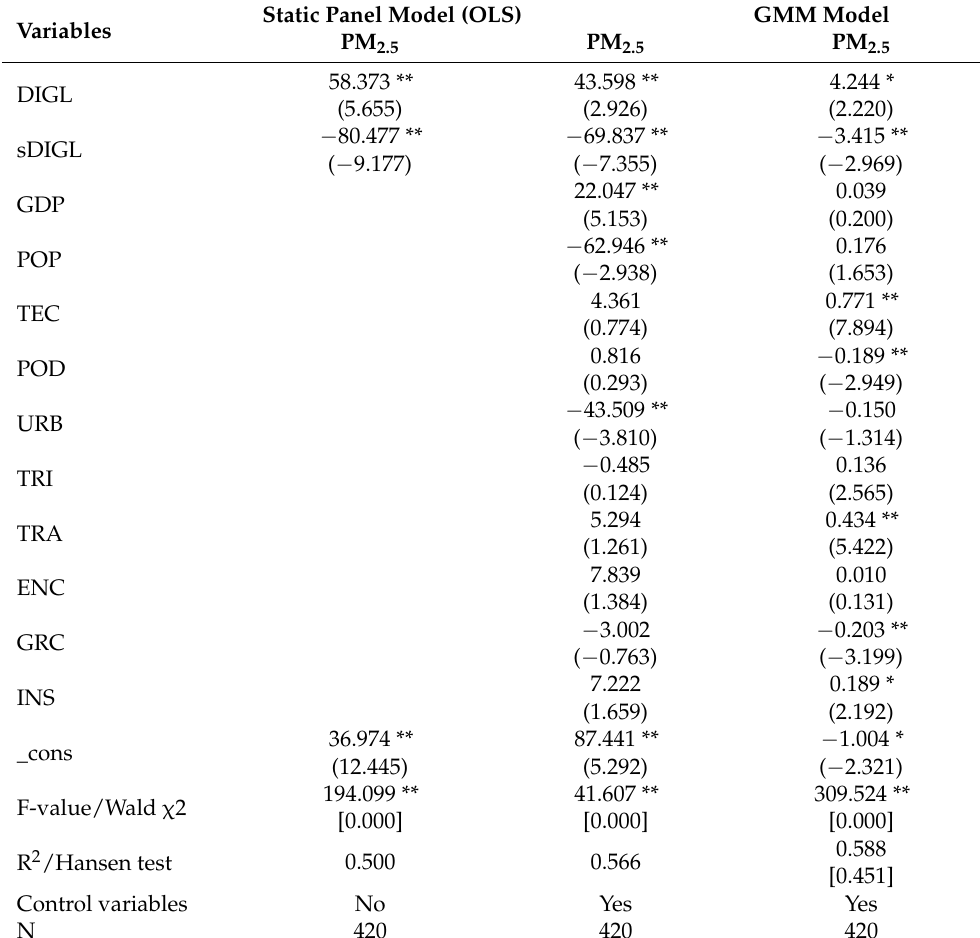
Table 3. The results of the benchmark